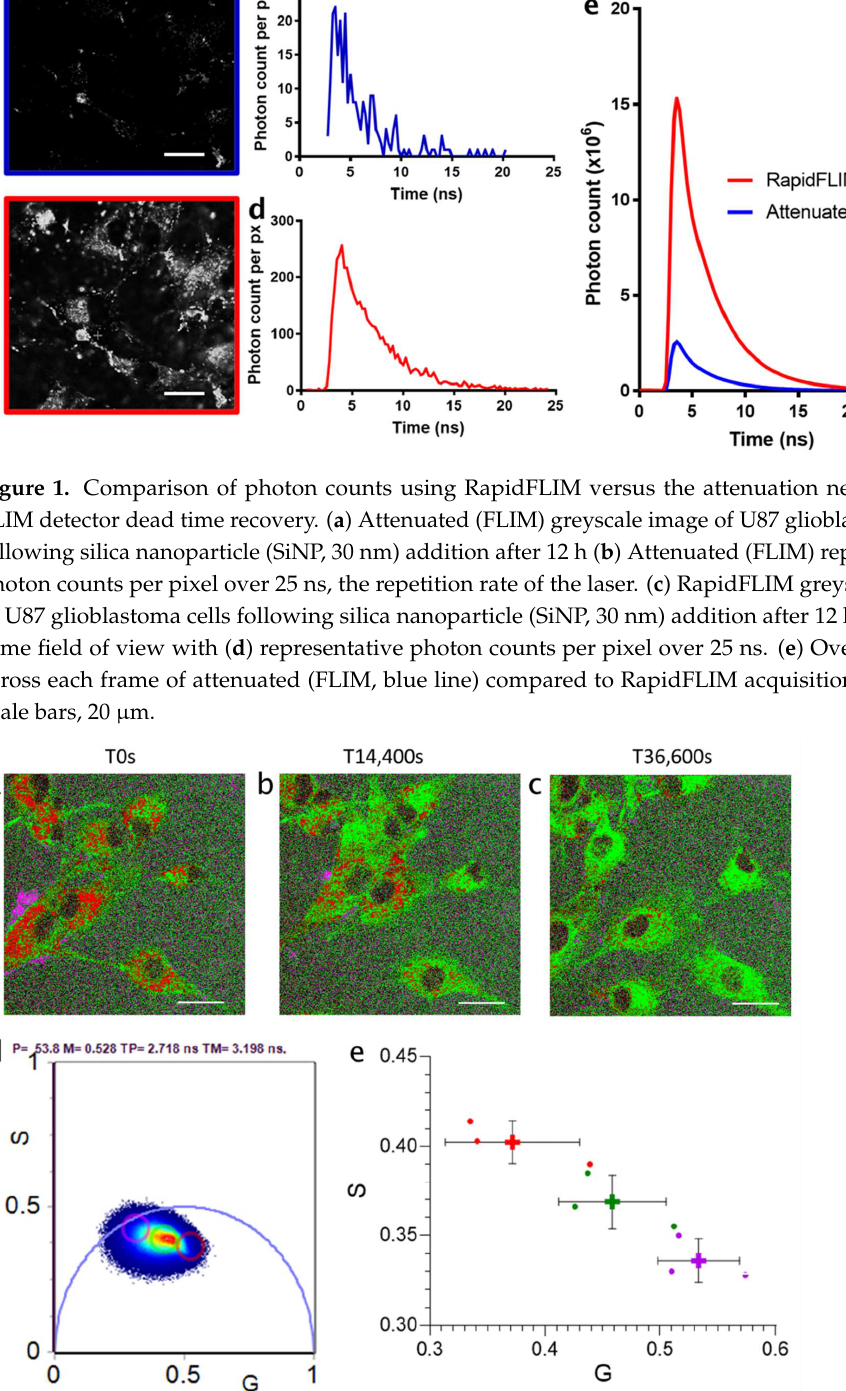
Figure 2. Time-lapse imaging of 30 nm silica nanoparticles (SiNP) uptake in U87 glioblastoma cells captured over 10 h (36,600 s) following SiNP addition. Representative phasor overlay for 30 nm SiNP at ( a ) time 0, ( b ) 4 h and ( c ) 10 h following SiNP addition, with ( d ) associated phasor plot and color coding (pink, long lifetime; green, intermediate lifetime; red, short lifetime). Representative of n = 3. ( e ) Consistency in independent phasor populations across multiple measurements. Points, individual biological replicates. Cross, mean of n = 3, Error SD. Scale bar, 25 μm.